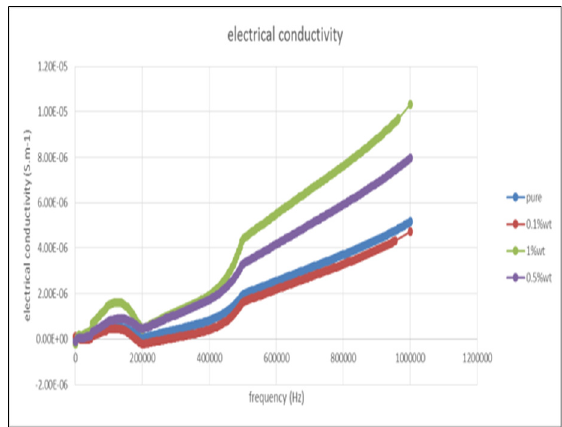
Fig. 16. Electrical conductivity's results for the nanocomposites with different MWCNT Ratios .